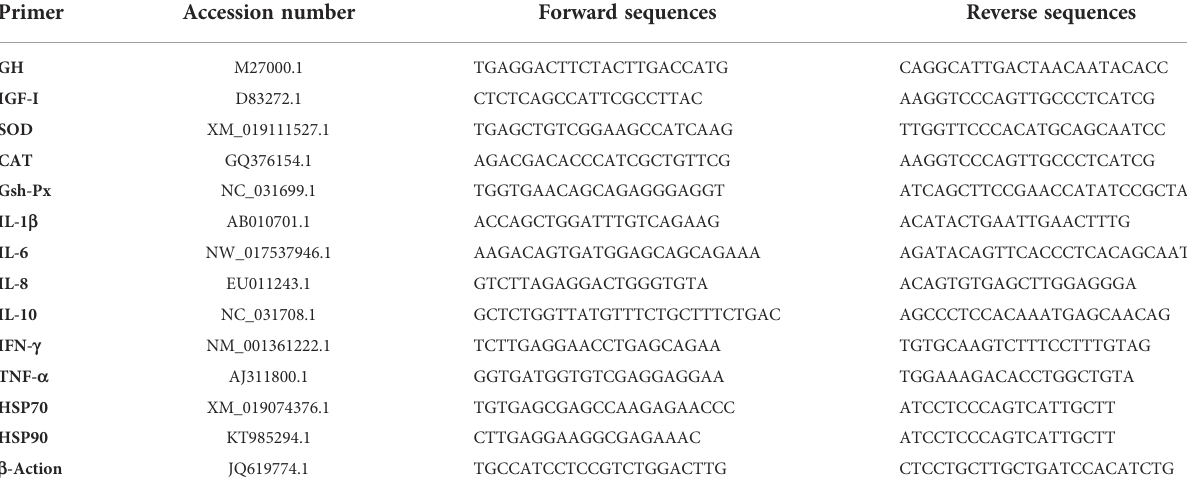
TABLE 3 Primers of Real-time PCR determination genes